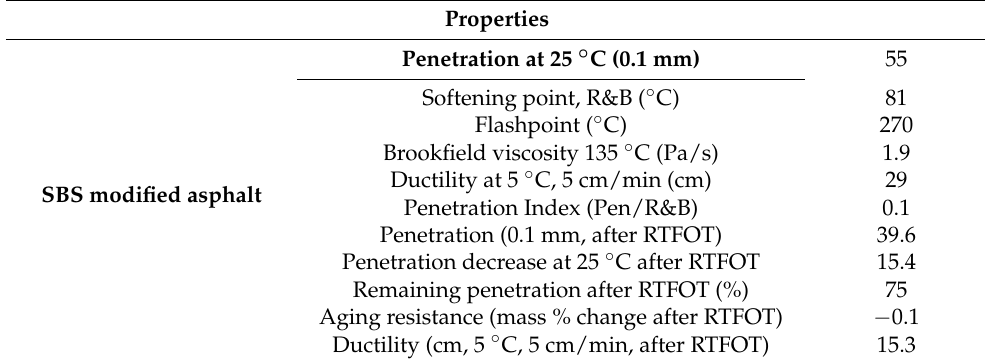
Figure 1. Curve and specification gradation envelope: ( a ) AC-13C mix design curve; ( b ) AC-20C mix design curve. Table 2. Properties of